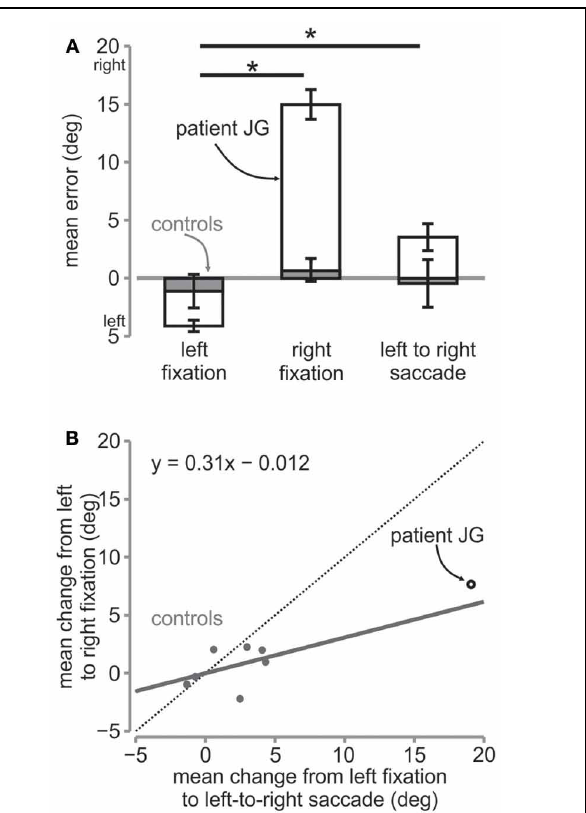
FIGURE 4 | Mean error and change in error. (A) Mean horizontal error in degrees for the three sessions for the patient (open bars) and the controls (gray bars). The error bars for the patient are s.e.m. across trials, while those for the controls are s.e.m across controls. The ∗ denotes significance at p < 0 . 05 across conditions for the patient. (B) Regression on mean change in errors. The mean change in error from left fixation to left-to-right saccade is plotted against mean change in error from left fixation to right fixation for controls (gray circles) and the patient (open black circle). The solid gray line is the line of best fit fitted to the control data. The regression equation is shown in the figure. The dotted diagonal line depicts the line of